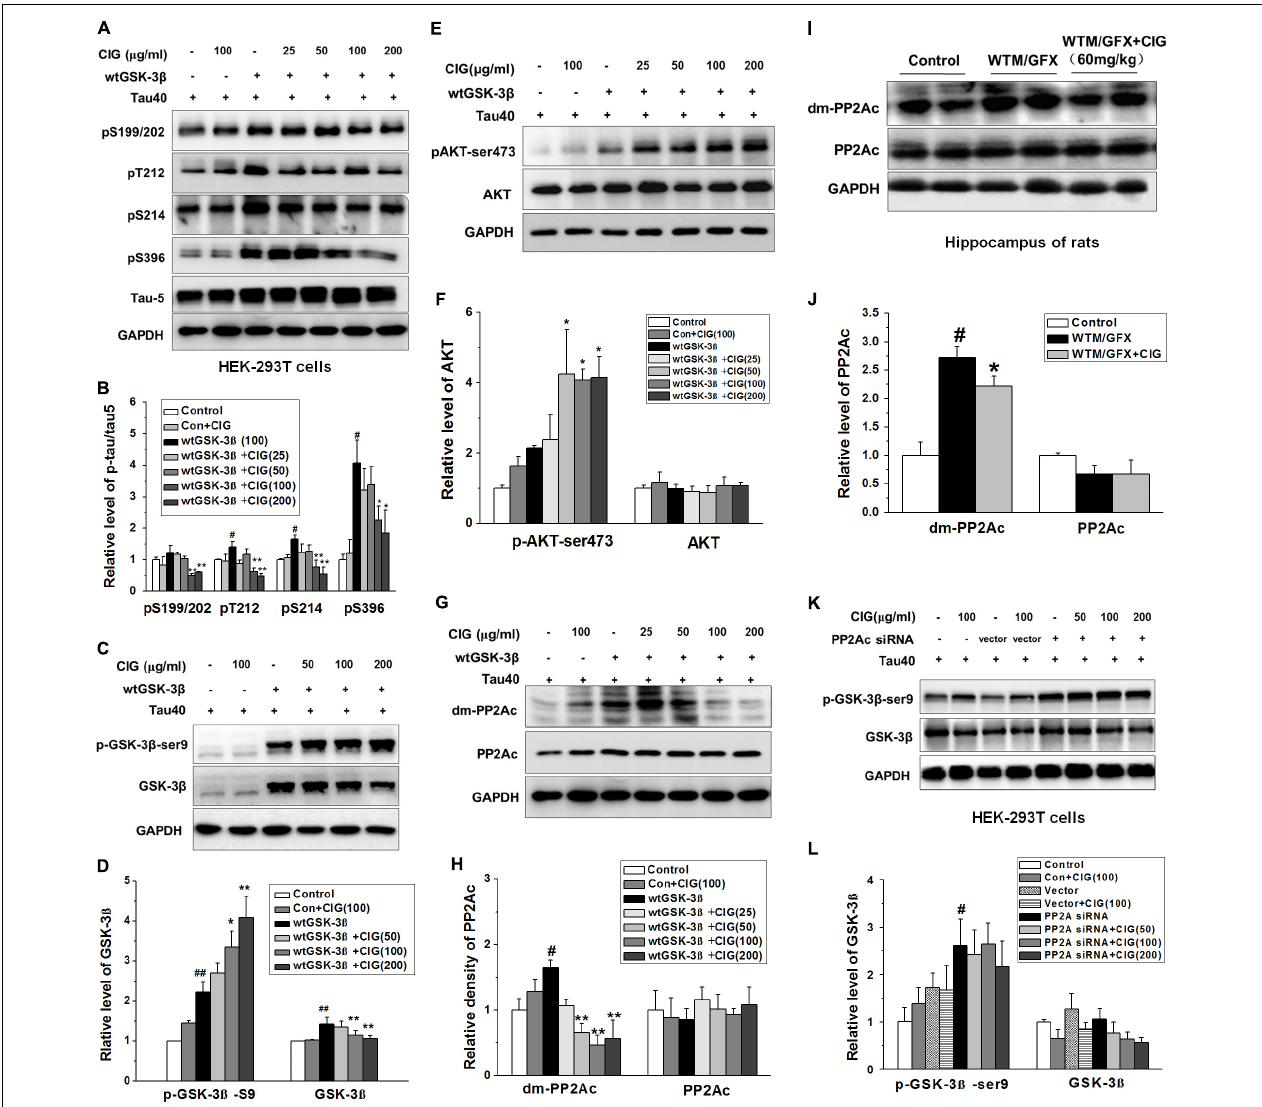
FIGURE 3 | Cornel iridoid glycoside inhibits GSK-3 β through decreasing PP2Ac demethylation to suppress tau hyperphosphorylation. (A,B) The phosphorylation at different sits of tau protein in HEK-293T cells transfected with wild type GSK-3 β plasmid together with human tau40 plasmid was detected by western blotting assay. CIG at different doses was incubated with transfected cells for 24 h. (C,D) The levels of GSK-3 β and phosphorylated GSK-3 β at Ser9 site in GSK-3 β -transfected cells. (E,F) Quantitative analysis of AKT and phosphorylated AKT at Ser473 in the cells transfected with GSK-3 β plasmid. (G,H) The levels of PP2A catalytic C subunit (PP2Ac) and demethylated PP2Ac (dm-PP2Ac) at Leu309 site in cells transfected with GSK-3 β plasmid. (I,J) The levels of PP2Ac and dm-PP2Ac at Leu309 in the hippocampus of rats intraventricularly injected with wortmannin/GFX. (K,L) The levels of GSK-3 β and phosphorylated GSK-3 β at Ser9 in HEK-293T cells transfected with PP2Ac siRNA. GAPDH was used as an internal control, and the expression level of control group was set as 100%. We detected p-tau and PP2Ac in the same electrophoresis and on the same membrane using different antibodies, and used the same loading control GAPDH in (A,G) . Data are present as mean ± SD; n = 3–4 each group. # P < 0.05, ## P < 0.01, the model group compared with the control group; ∗ P < 0.05, ∗∗ P < 0.01, drug groups compared with the model group. WTM, wortmannin; GFX, GF-109203X; MEM, memantine, 3